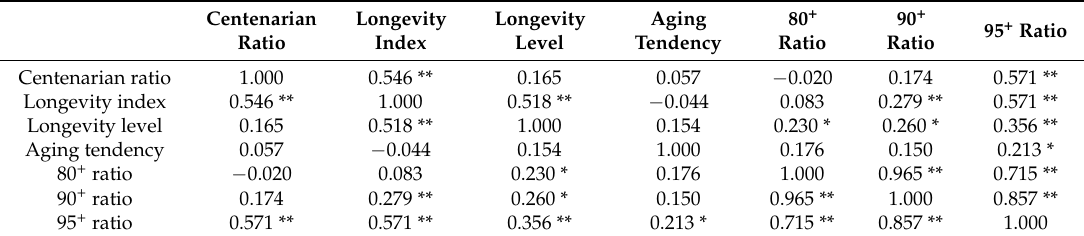
Table 5. The correlation analysis between the seven longevity indicators in